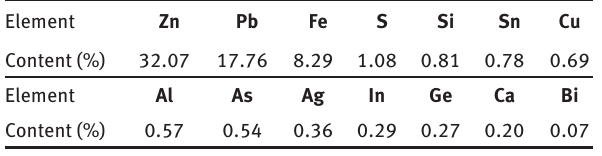
Table 1: The main element contents of raw material.